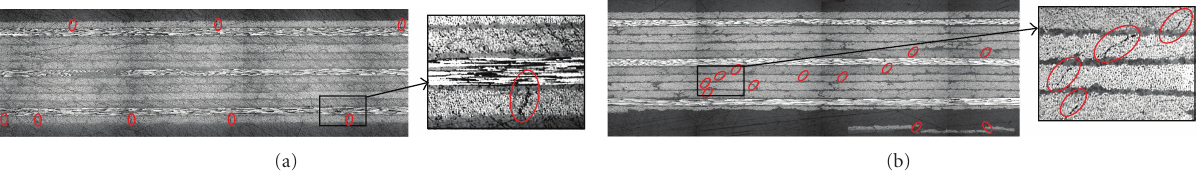
Figure 5: Posttest micrographs of specimen centre (a) with tensile preload and impact velocity of 171m/s (443 J) and (b) with compressive preload and impact velocity of 170 m/s (449J), matrix cracks are